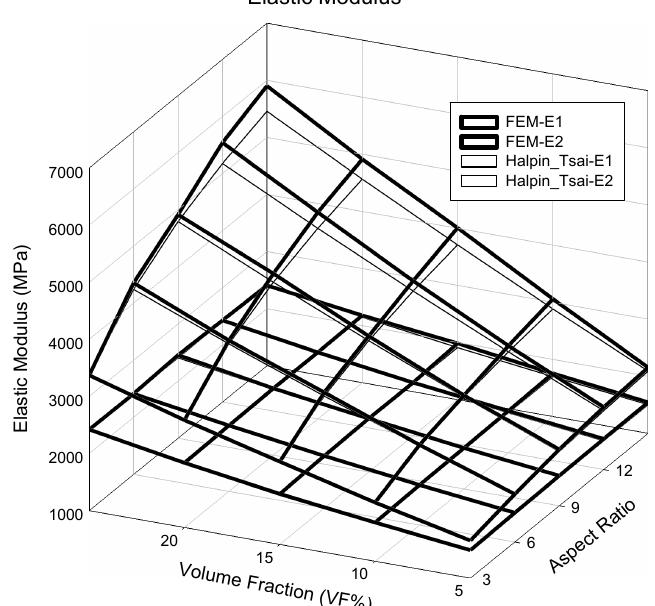
Figure 4. Elastic modulus result based on the volume fraction and aspect ratio.